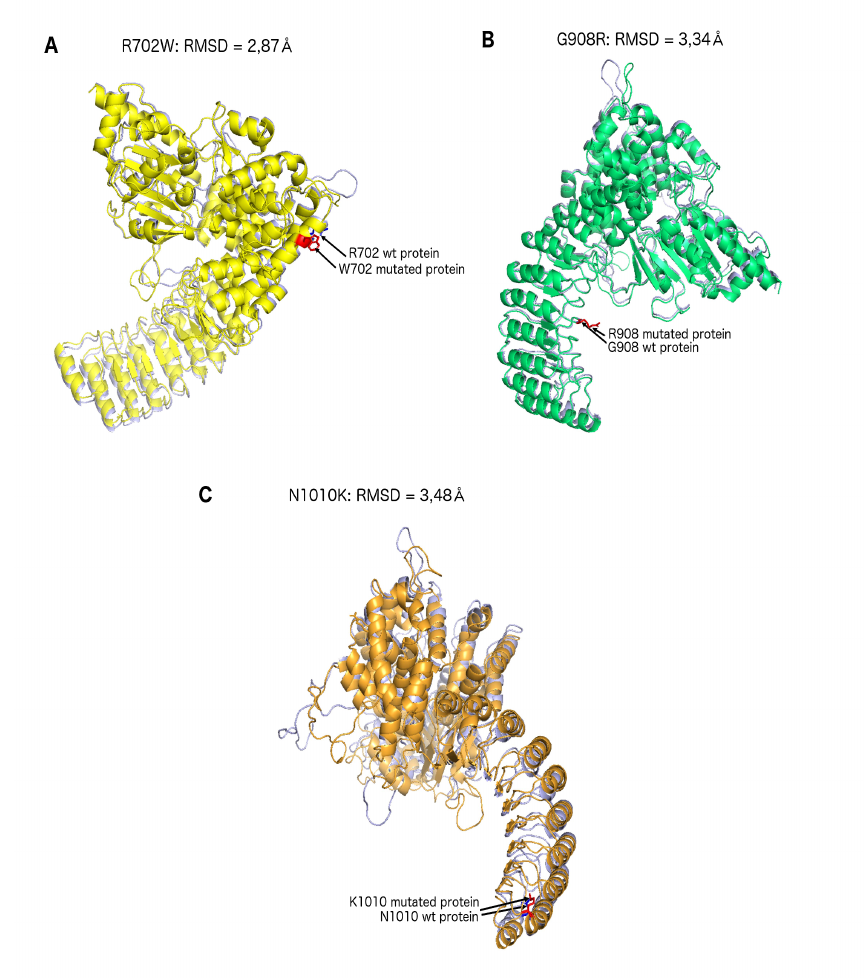
Figure 3. ( A ) Structural predictions of the human native NOD2 protein (amino-acids 219–1040) and the human R702W mutated NOD2 proteins (amino-acids 219–1040); ( B ) structural predictions of the human native NOD2 protein (amino-acids 219–1040) and the human G908R mutated NOD2 proteins (amino-acids 219–1040); ( C ) structural predictions of the human native NOD2 protein (amino-acids 219–1040) and the human N1010K mutated NOD2 proteins (amino-acids